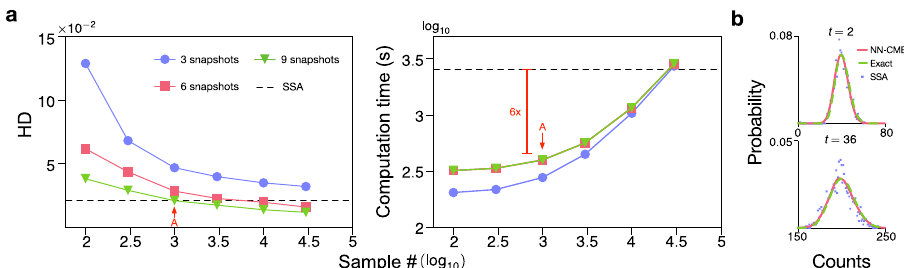
Fig. 3 Evaluating the performance of the ANN-aided model approximation. a Precision and computational ef fi ciency of the ANN-aided model approximation as a function of sample size and number of snapshots. The method is benchmarked on Model I since the time-dependent solution of the delay CME is exactly known (see SI Note 1) and hence the accuracy of our method can be precisely quanti fi ed. A measure of the accuracy is the average Hellinger distance (HD) between the NN-CME and exact distributions at four different time points. The computation time is equal to the time-to-acquire samples plus time for training. Each data point in the graphs is averaged on three independent trainings. Note that the NN-CME obtained from training with 10 3 samples produces a distribution that is as precise as that from 3 × 10 4 samples using the SSA of the delay CME (shown as a black dashed line); in this case the computation time of the NN-CME is also just 1/6 of the SSA. b Comparison of the NN-CME distributions, exact analytical distributions and histograms from stochastic SSA simulations of the delay CME at two different time points; the sampling for both training and the SSA is 10 3 . Note that the NN-CME leads to much more accurate distributions than the SSA for the same number of samples. The rate constants and other parameters related to the ANN ’ s training are speci fi ed in SI Table 1.